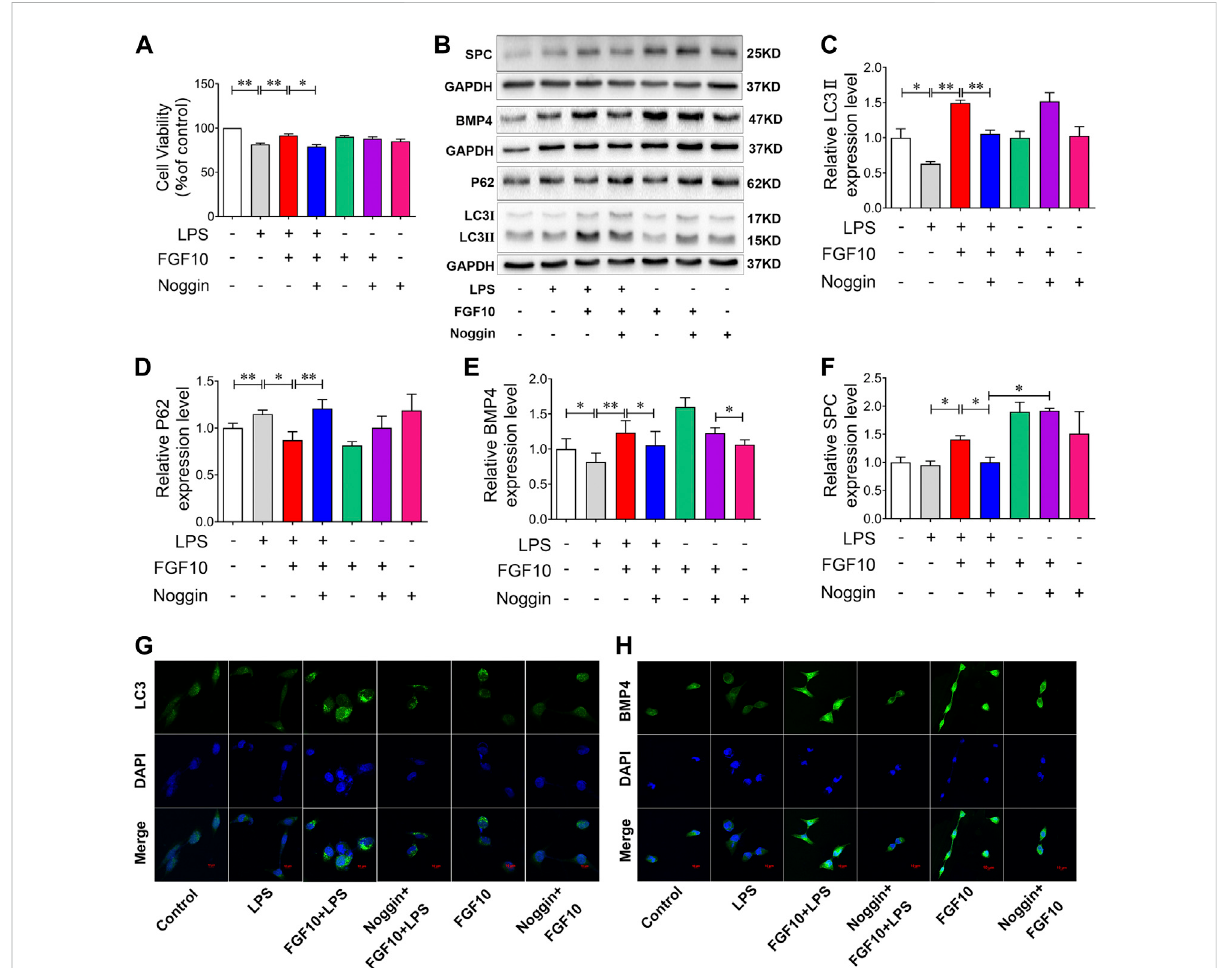
FIGURE 6 Inhibition of BMP4 decreases the protective role of FGF10 on AECs via autophagy. (A) After exposure to 200 ng/ml of Noggin for 0.5 h and 10 ng/ml of FGF10 for 1 h, the viability of AECs with 10 μ g/ml LPS administration was detected by CCK-8. (B) The protein expression of LC3, P62, BMP4, and SPC was examined by Western blotting. (C – F) Quantitative analyses of LC3, P62, BMP4, and SPC protein. (G,H) The expression of LC3 (green) and BMP4 (green) of AECs were analyzed by immunostaining (magni fi cation ×400). The data were presented as the mean ± SEM, n = 3. * p < 0.05, * * p <